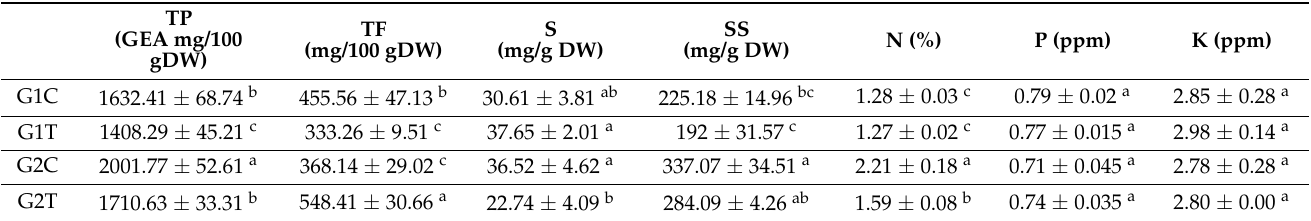
Means with the same letter in the same column are not significantly different from each other according to Tukey’s test ( p < 0.05). Error lines represent ± standard deviation of the mean. Different letters ( a,b,c ) indicate statistically significant differences according to Tukey’s test ( p < 0.05).